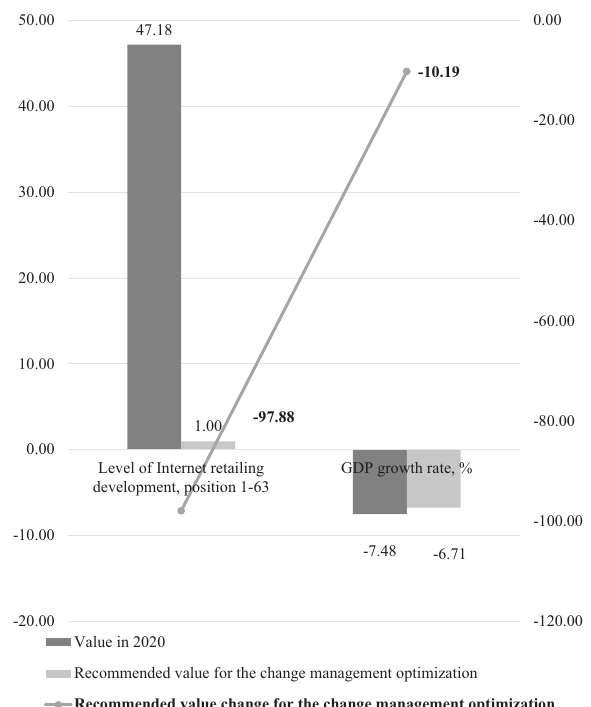
Fig. 6 Recommendations for optimizing the effectiveness of change management measures to contain social drama amid the unfolding